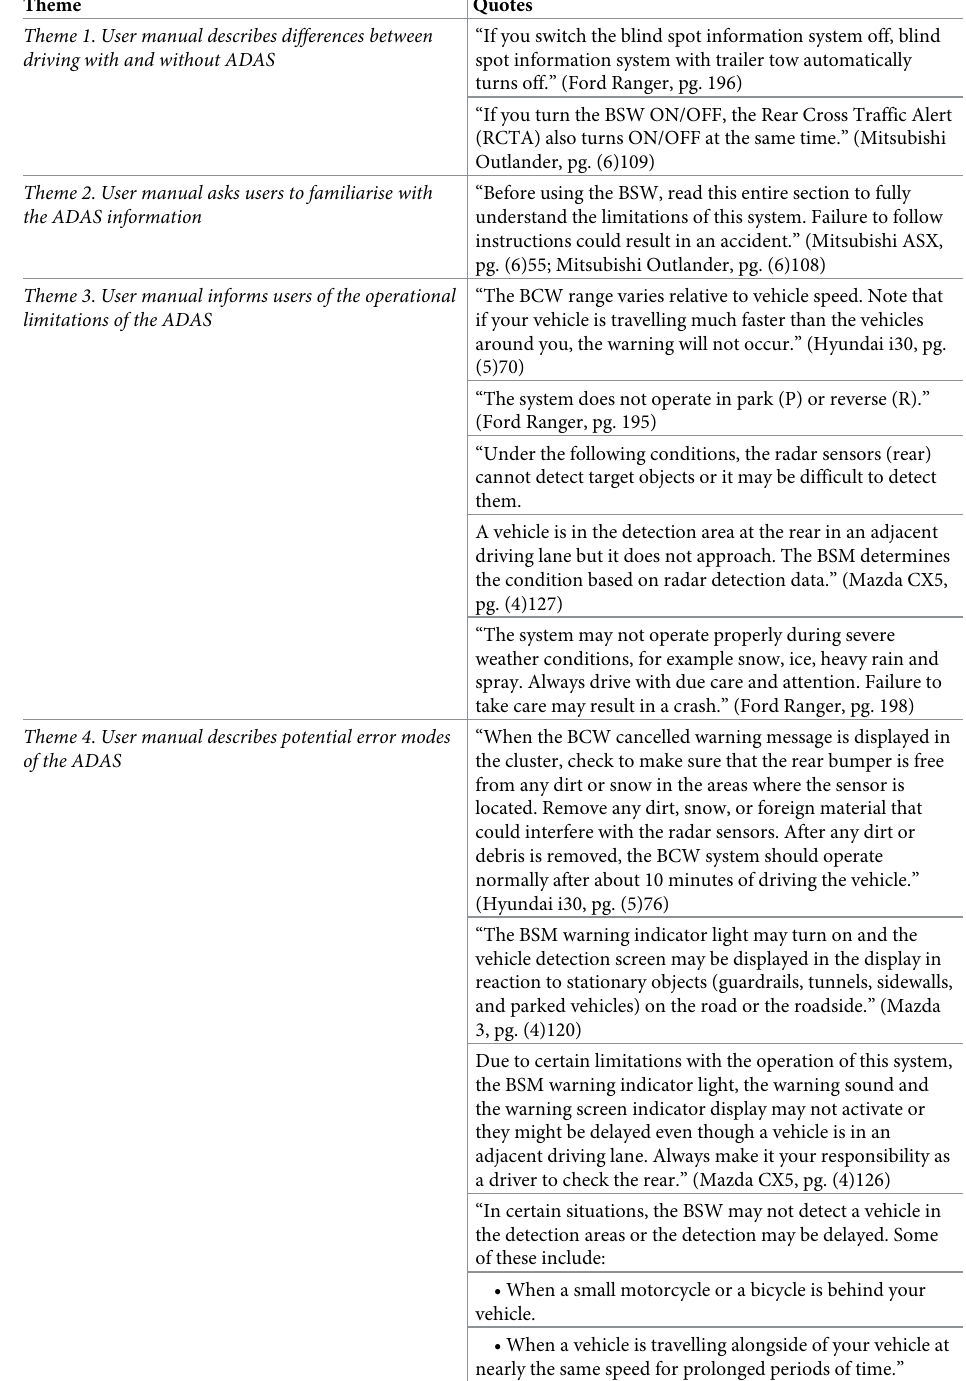
Table 1. Qualitative analysis of blind sport monitoring